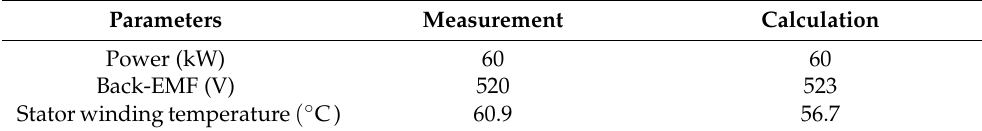
Figure 28. Prototype. Table 9. Structure parameters of the rotor shape for HSPMM under the three cases.